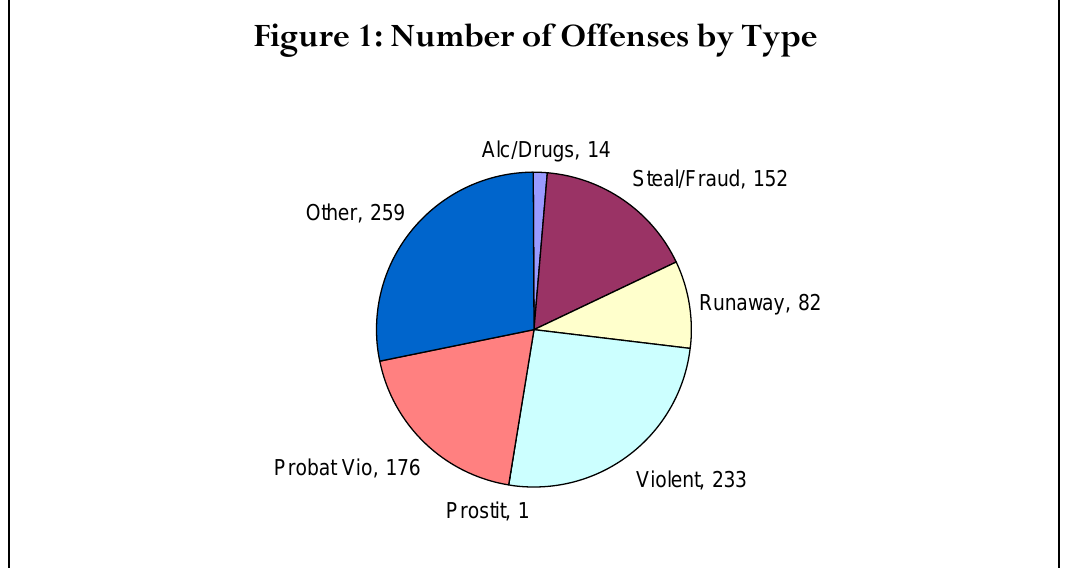
Figure 1: Number of Offenses by